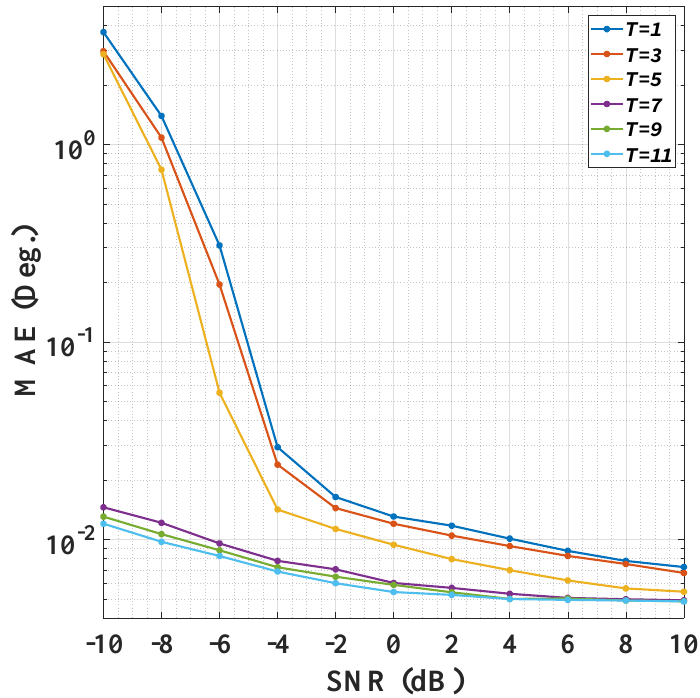
Figure 7. MAE versus SNR curve of the proposed method with different number of